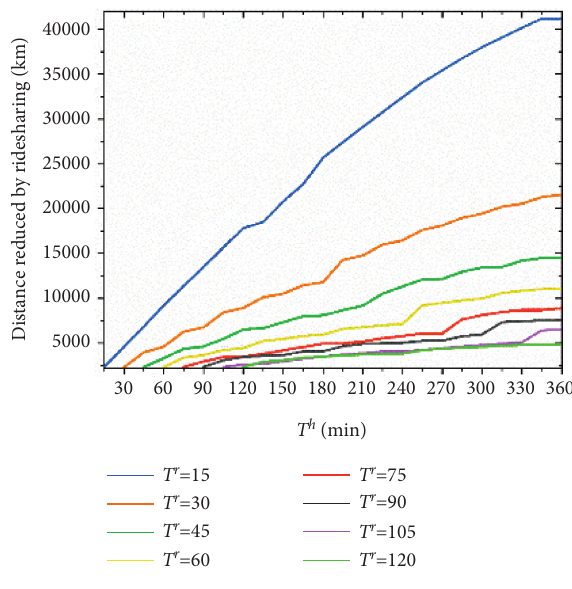
Figure 9: Results of fare.